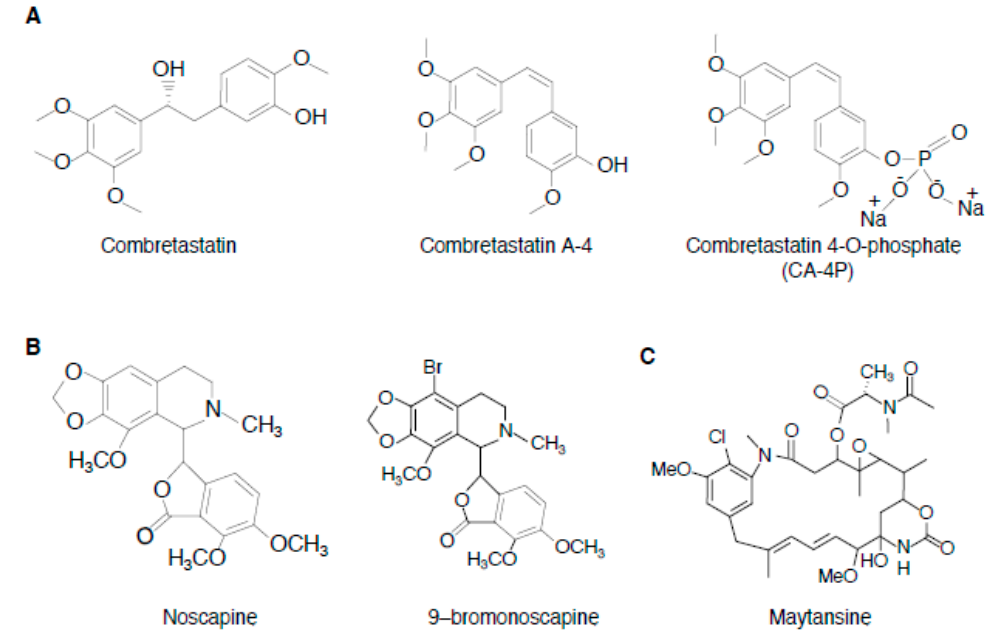
Figure 5. Chemical structures of ( A ) combretastatins, ( B ) noscapine and 9-bromonoscapine, and ( C ) maytansine.